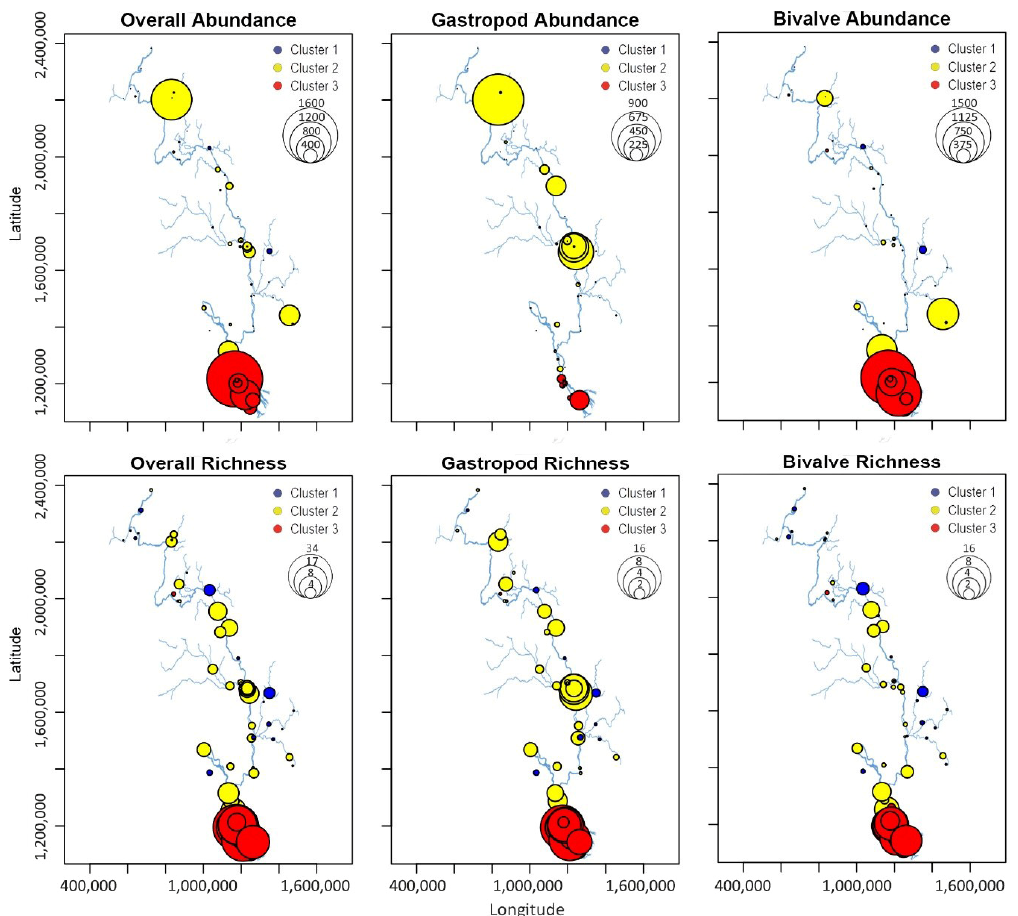
Figure 3. Abundance and richness distribution of overall mollusc communities, gastropods and bivalves in the Lower Mekong Basin.